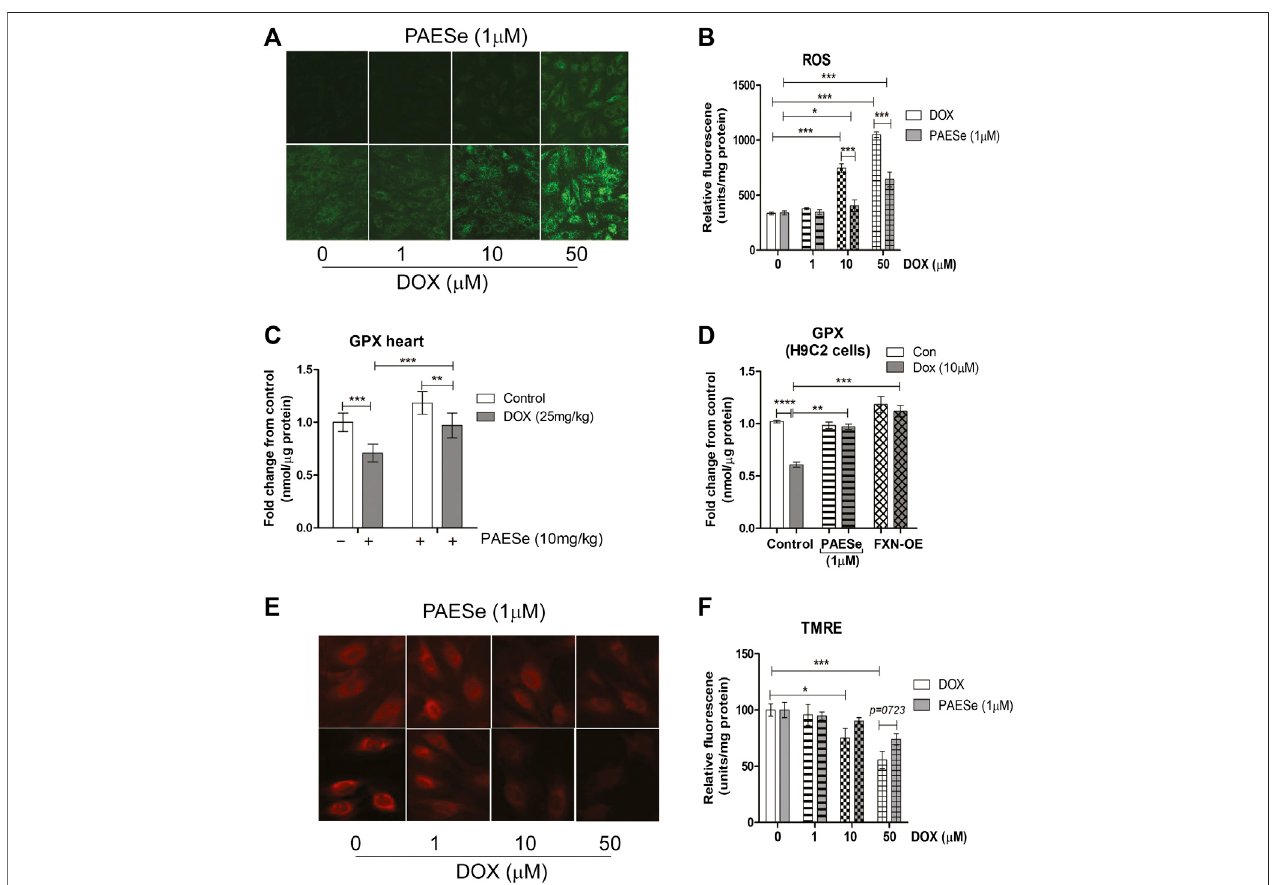
FIGURE5| PAESeprotectsagainstDOXmediatedmitochondrialROSformation. (A,B) FluorescenceimagesofmitochondrialROSformation(green)inincreasing concentrationsofDOX(0 – 50 µM)treatedH9C2cellswithorwithoutPAESe(1 µM)andgraphicalrepresentationofROSlevelsinH9C2cardiomyoblasts. (C) Glutathione peroxidaseactivity,mitochondrialheartlysatefromDOXtreatedathymicmicewithandwithoutPAESe(cumulativedosingof(DOX25 mg/kg) ± PAESe(50 mg/kg/dose). (D) Inaddition, GPxactivity wasmeasured inisolatedmitochondriafrom H9C2cellstreatedwithDOX(10 µM)orPAESe(1 µM)treatedandnon-treated H9C2and FXN-OE cardiomyoblasts. (E , F) Mitochondrial membrane potential ( Δψ m ) determined by TMRE (2 μ M) immuno fl uorescence in DOX treated (1 – 50 µM) H9C2 cells with and without PAESe (1 μ M) for 24 h where N (cid:2) 4 independent experiments and are represented as mean ± S.E.M. and analysis was accomplished by student t-test with post-hoc analysis for signi fi cances between groups and within groups based upon averages from the assays. *; p < 0.05 **; p < 0.001, ***; p < 0.0001.